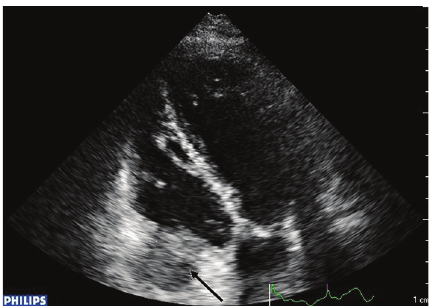
Figure 1: Nodular lesion at chest X-ray. Chest radiography showing bilateral nodular lesions, above all in lower lung fields.